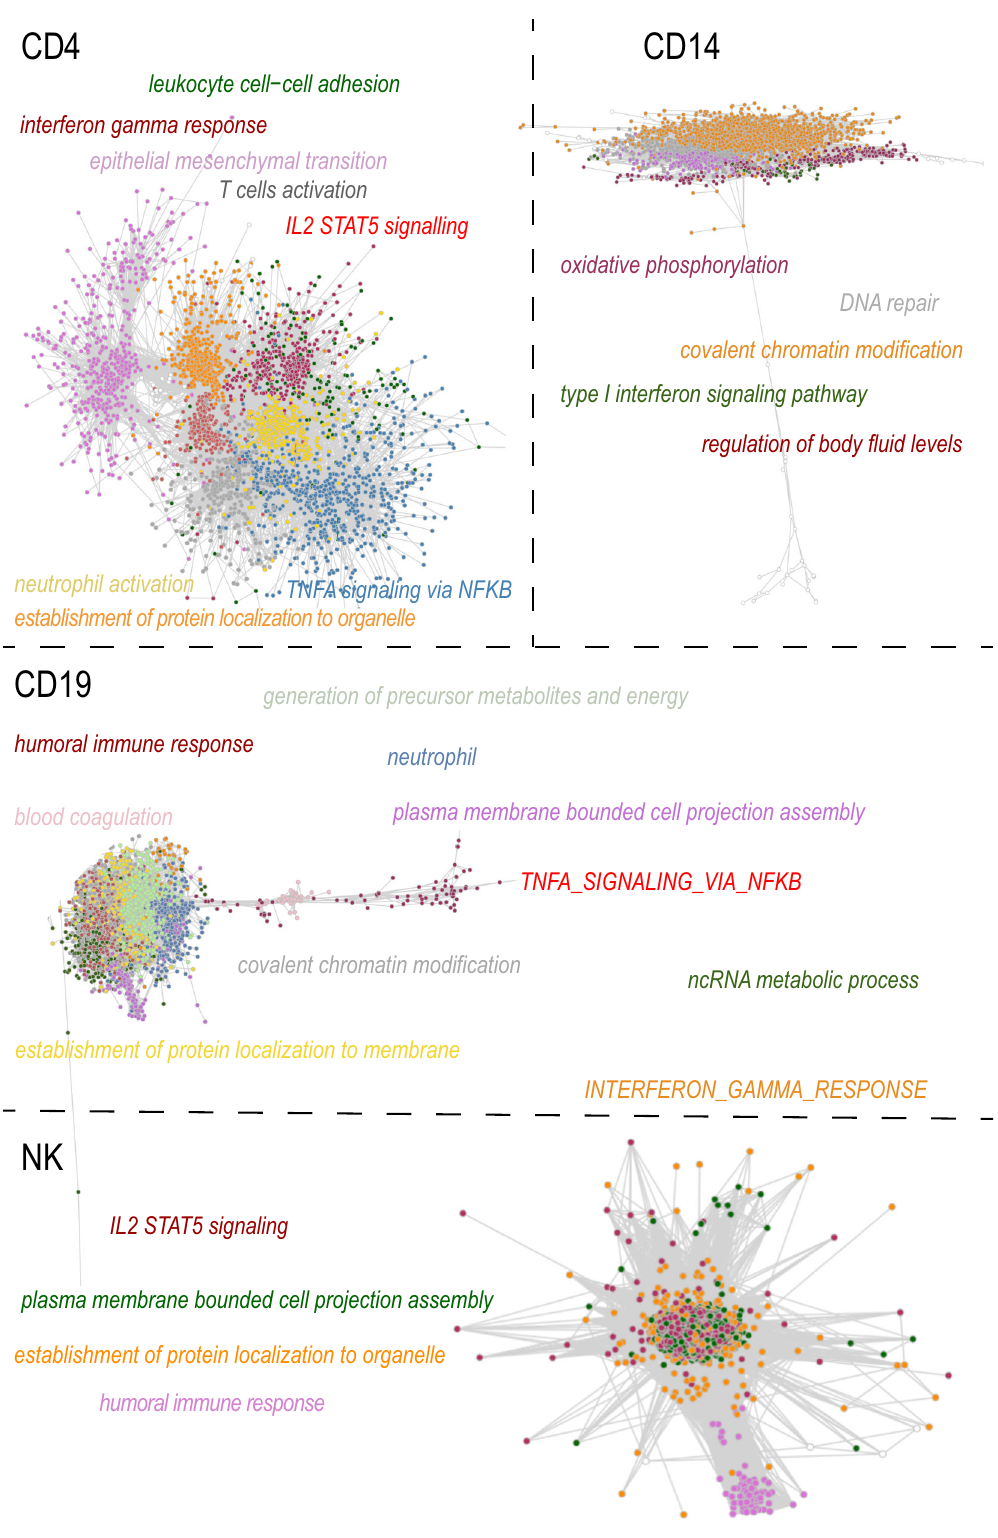
Fig. 5 Network visualization of gene co-expression analyses. Visualization of the CD4, CD14, CD19, and NK cells CoCena2 network. Nodes are genes and edges represent co-expressed genes. Additional module information is displayed by module-colored labels. Labels include information about top-GO terms, as well as representative Hallmark